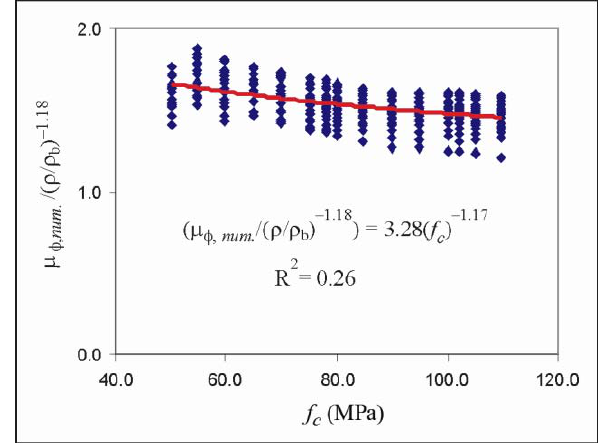
Fig. 3. Influence of   18.1 /  